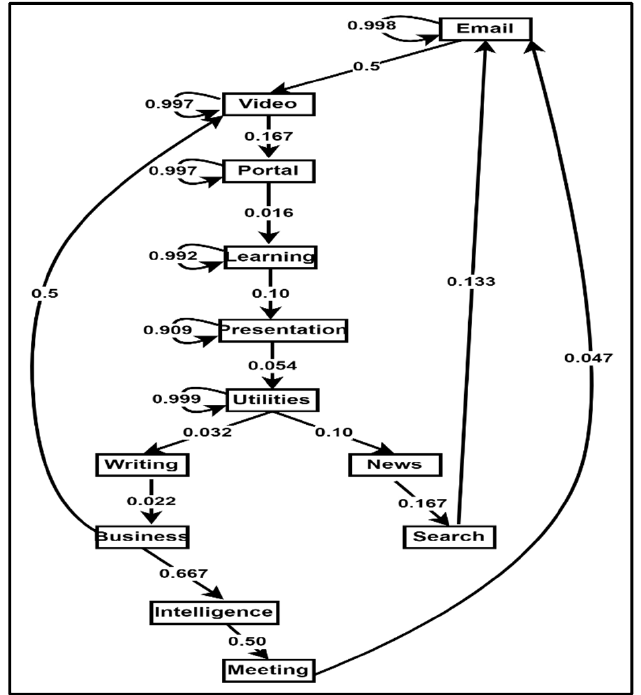
Figure 13. Activity model for P3.